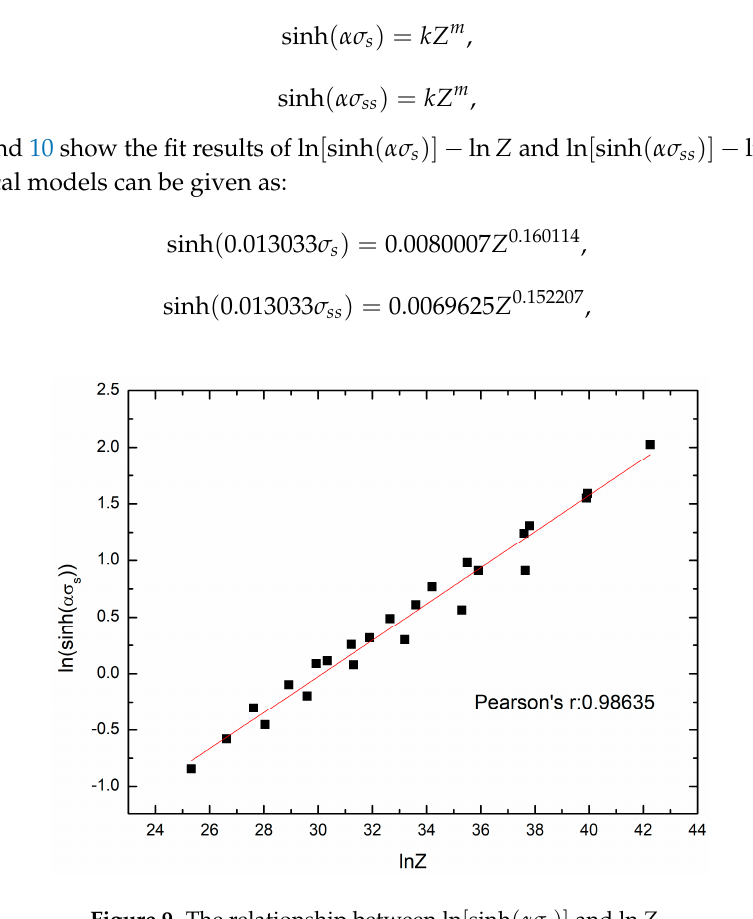
Figure 9. The relationship between ln [ sinh ( ασ s )] and ln Z .